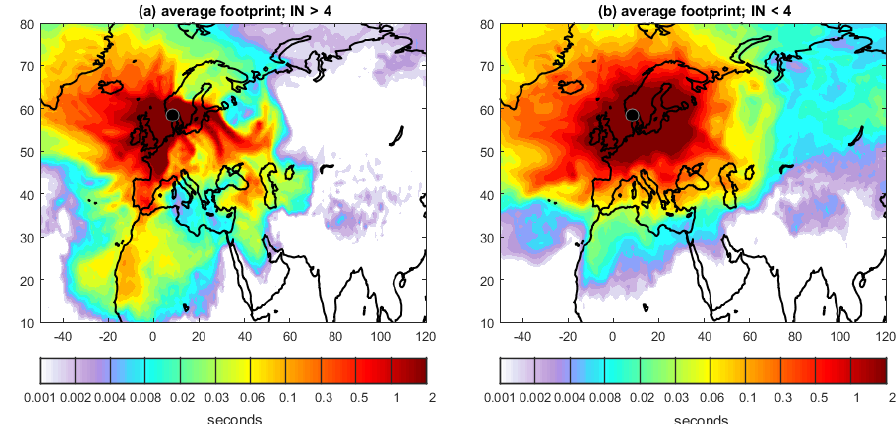
Figure 3. Source receptor sensitivity (SRS) fields for situations with > 4 INP − 8 m − 3 (a) and when INP − 8 were < 4m − 3 (b) as derived from FLEXPART. The SRS unit is seconds, which would result in a mass concentration (kgm − 3 ) at the receptor when multiplied with an emission flux (kgm − 3 s − 1 ) into the model grid cells. Since emission fluxes are not known for INP − 8 , SRS values can be considered as a measure of relative impact that INP emissions from a particular area would have had on INP concentrations at Birkenes. The potential influence was strongest from areas shown in red and weakest from those in white and purple.